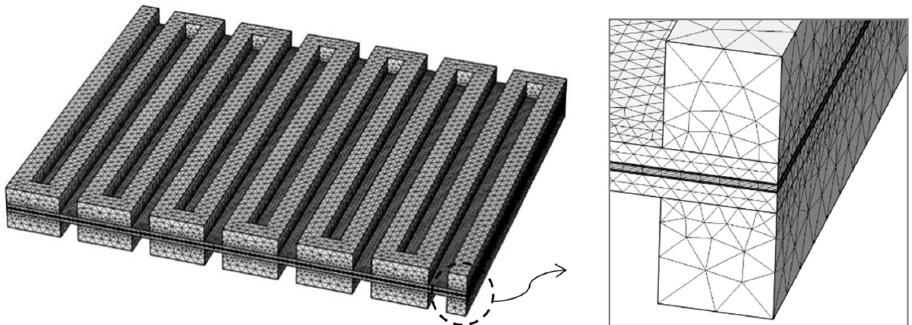
Figure 3. Mesh distribution for the entire 3D model along with the enlarged view near the inlet section. Fine structured hexahedral mesh elements are employed in the membrane and catalyst layers, while coarse unstructured tetrahedral mesh elements are used in the other sections.